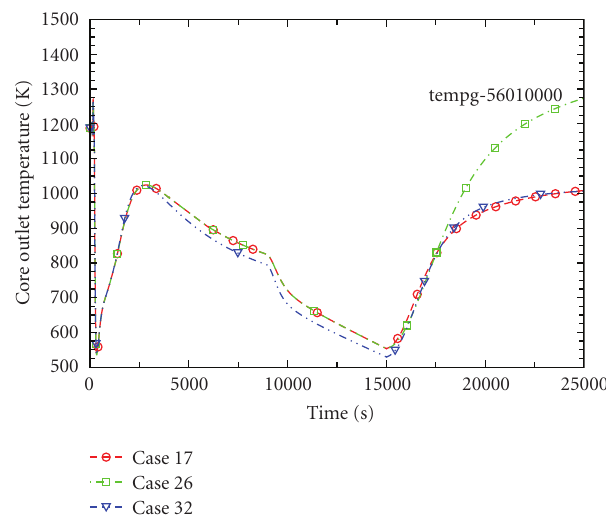
Figure 13: Core outlet temperature.